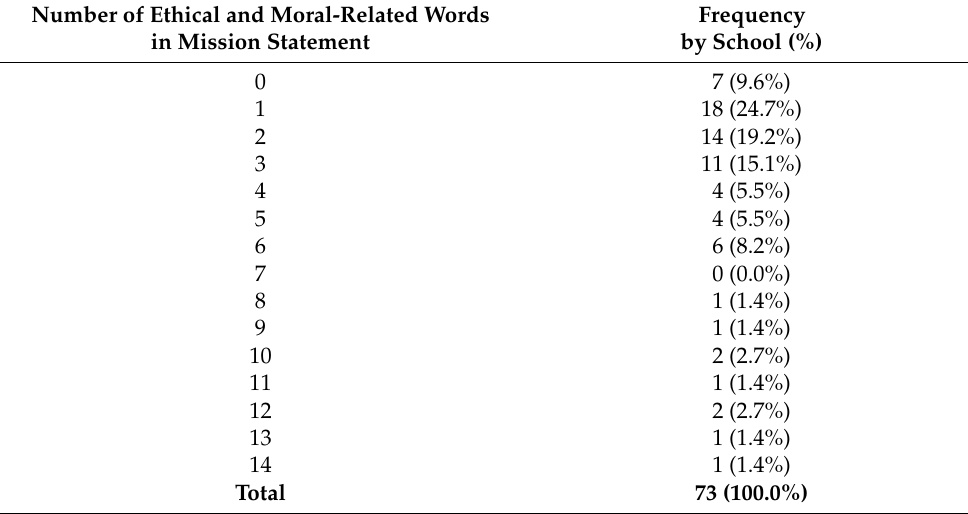
Table A2. Frequency of Morally Relevant Words in Mission Statements. Number of Ethical and Moral-Related Words